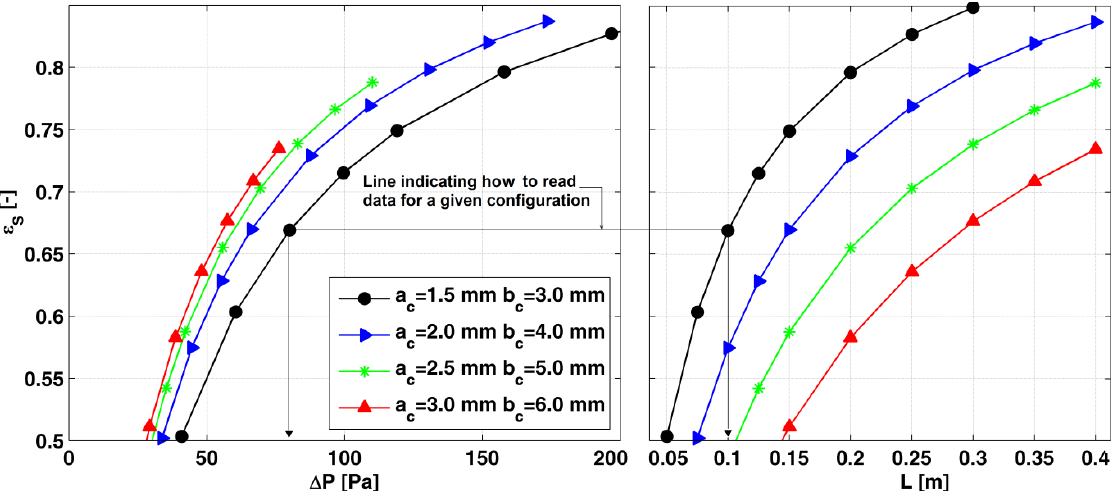
Figure 9. Optimal wheel configurations at constant channel aspect ratio b c /a c =2 and at v f = 2.5 m·s −1 for different length ( T su,in = 10 °C, T ex,in = 30 °C, X su,in = 3.7 g·kg −1 , X ex,in = 7.7 g kg −1 , φ su,in = 50%, φ ex,in = 30%, s = 0.05 mm and N = 10 rev·min −1